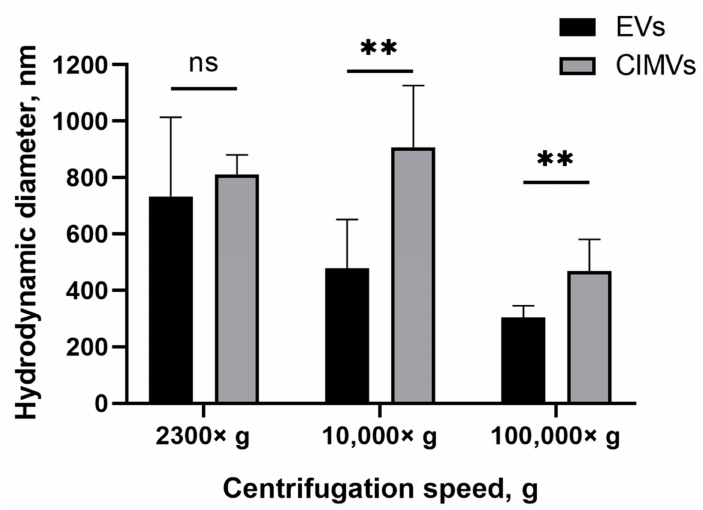
Figure 3. Average diameter of mouse EVs and CIMVs centrifuged at 2300 × g , 10,000 × g , and 100,000 × g . Method—dynamic light scattering. The data represent mean ± SD. ns—not statistically significant. (**)—level of significance p < 0.01.